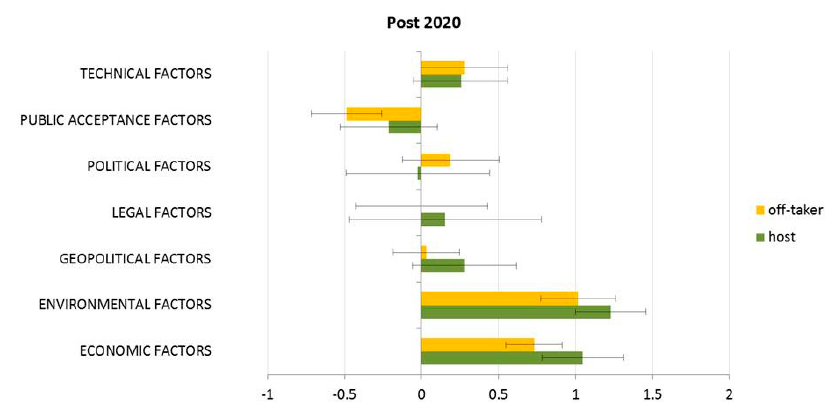
Figure 3. Factor relevance per category for off-taker and host countries (future). Source: Own elaboration. The end of the bars indicate observed means and the horizontal line segments ("error bars") represent the confidence intervals around them. No significant differences have been found.